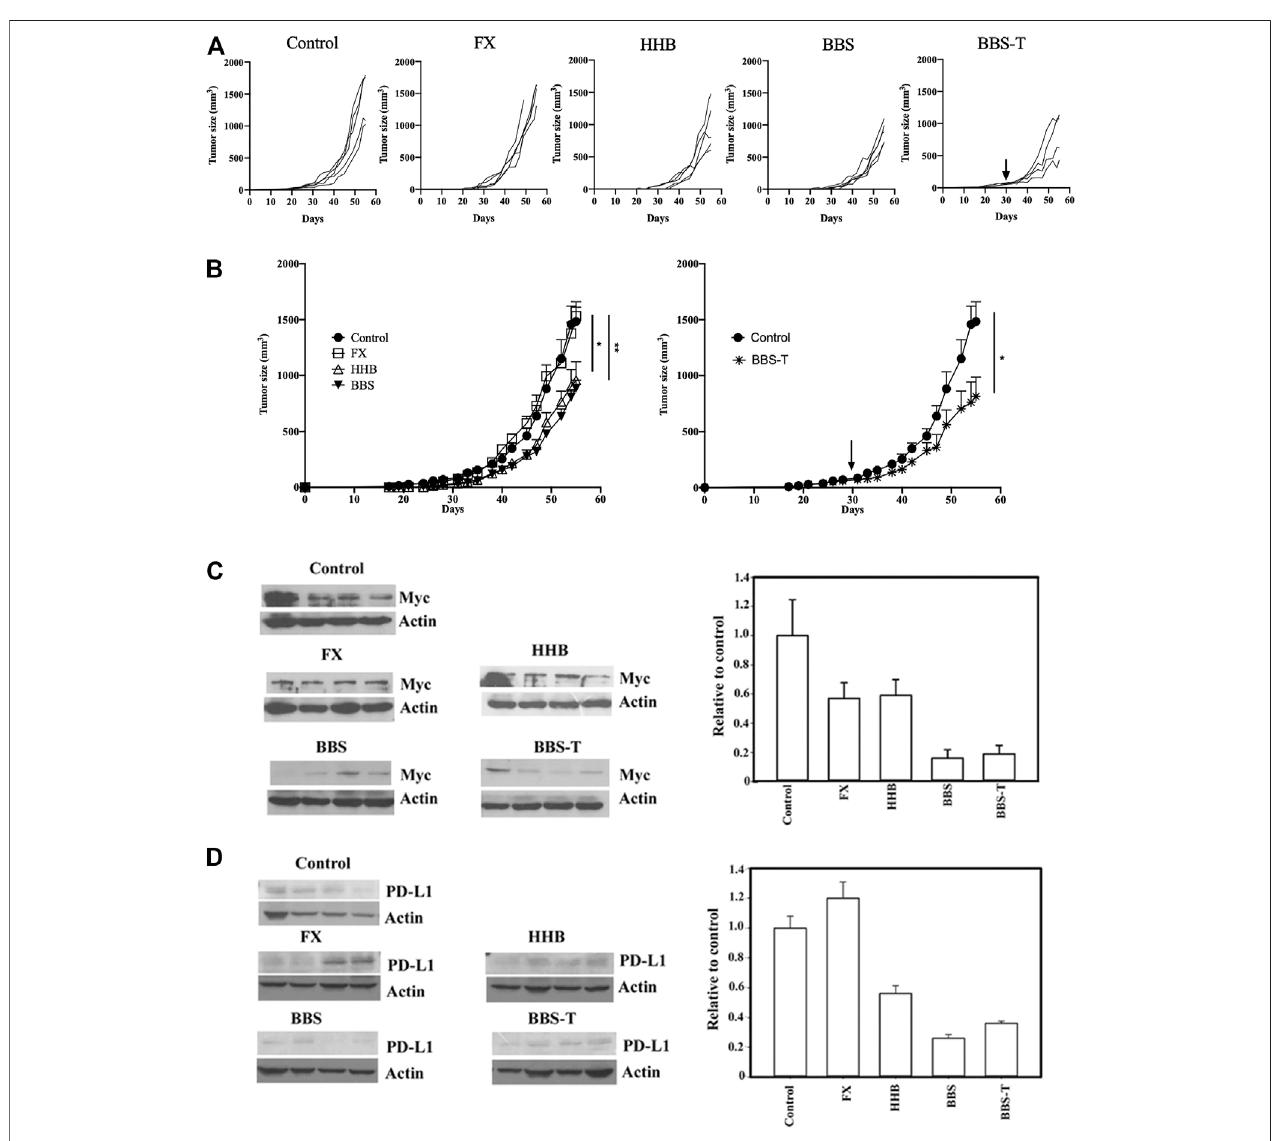
FIGURE 8 | The antitumor effect of formula FX/HHB/BBS treatment. (A) Pan18 tumor-bearing mice (4-5 animals/group) were orally administered ddH 2 O (control), Formula X (FX), HHB, or BBS on Day 7 or orally administered formula BBS on Day 31 (to detect potential therapeutic effects; BBS-T). Each curve represents each individual mouse. (B) The results were pooled and are expressed as the means ± SEMs. The tumor diameters are shown (mm 3 ). * p < 0.05 , ** p < 0.01 . The lysates from thetumorsofeachsacri fi cedmouseweresubjectedtoWesternblottingtodetecttheproteinlevelsofMyc (C) andPD-L1 (D) .Noparticularregionoftheimagewas solely manipulated. The density of each band was determined by an internet available program (ImageJ) and normalized to the density of the actin band. The data are expressed as the fold change relative to the levels observed in the control ±SD (right panel of Figures C and D).